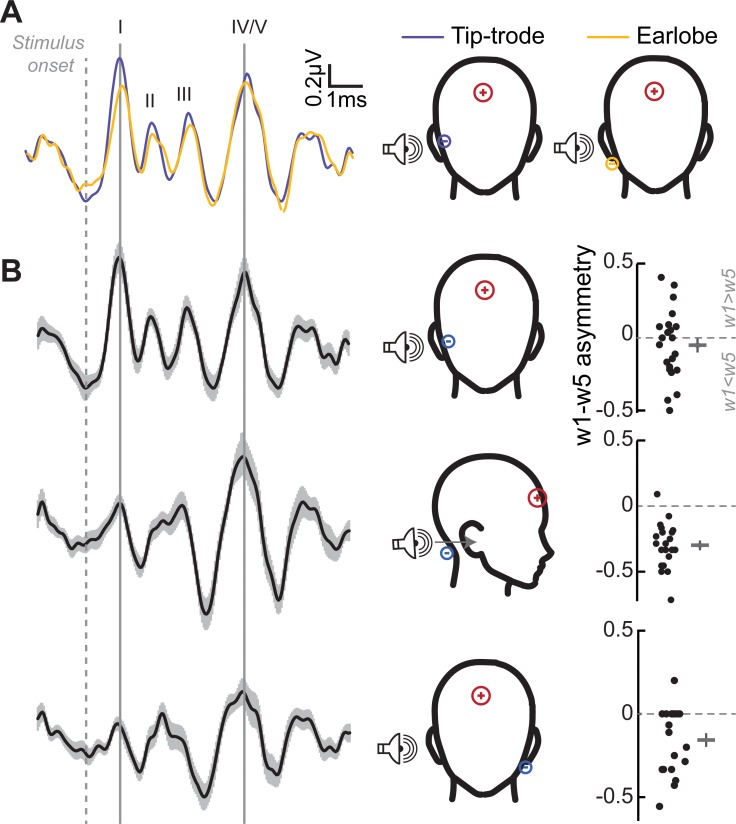
Determination of optimal electrode montages for obtaining electrophysiological responses.(A) Grand-averaged ABRs elicited by 3 kHz tones at 105 dB SPL, and recorded simultaneously with an electrode on the ear lobe (yellow), and a gold-foil coated ‘tiptrode’ inserted in the ear canal (blue), shows greater amplitudes using tiptrodes for wave 1, with generators in the auditory nerve, but not wave 5, with midbrain generators. (B) Simultaneous multi-channel recordings reveal differential contributions from auditory generators for each electrode montage. Grand-averaged ABR waveforms (left) for three electrode montages show the differential contributions of the ABR waves for each montage, reflecting emphasis on peripheral vs. central generators. The relative amplitudes of waves 1 and 5 is characterized by the w1-w5 asymmetry index (right) with values > 0 having a larger wave 1, and values < 0 having a larger wave 5. Gray bars represent the mean asymmetry index, and error bars represent SEM.Figure 2—figure supplement 1—source data 1.ABR wave 1 – wave 5 indices for various electrode montages.